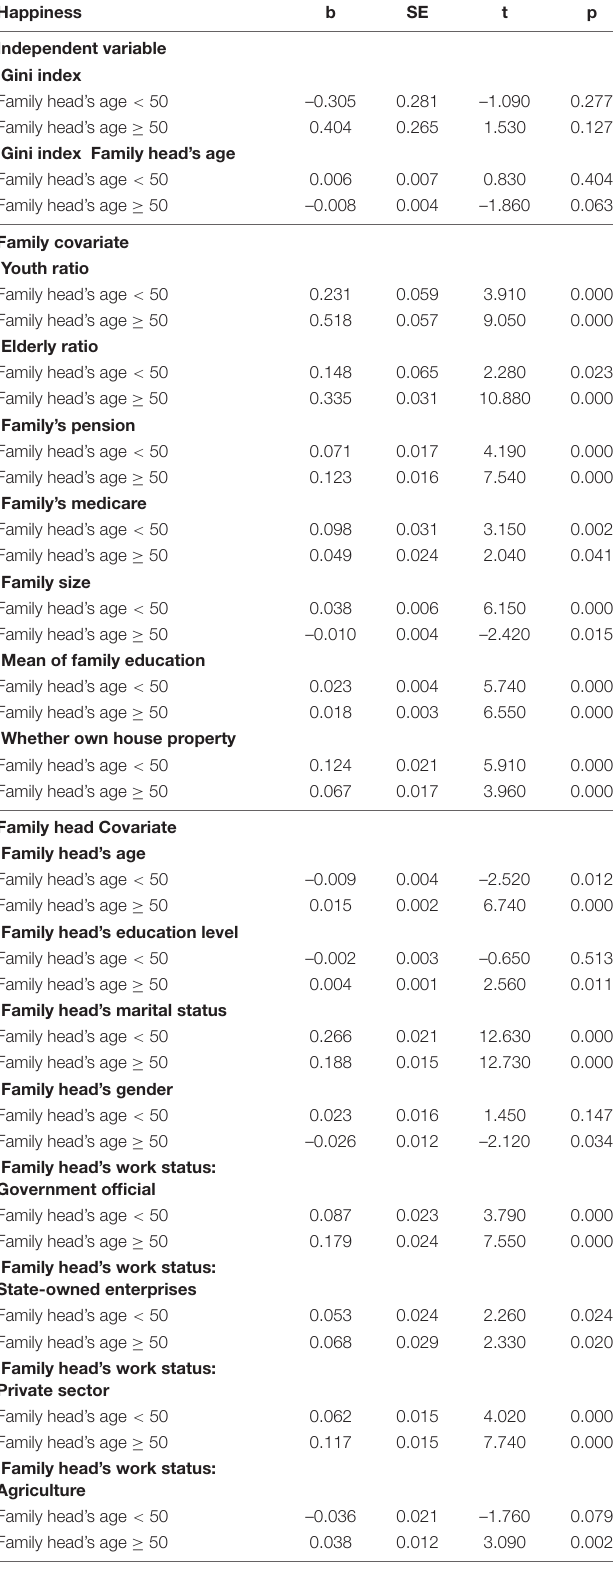
TABLE 5 | Moderating effect regression on happiness with the wealth Gini index throughout the life cycle. Happiness b SE t p